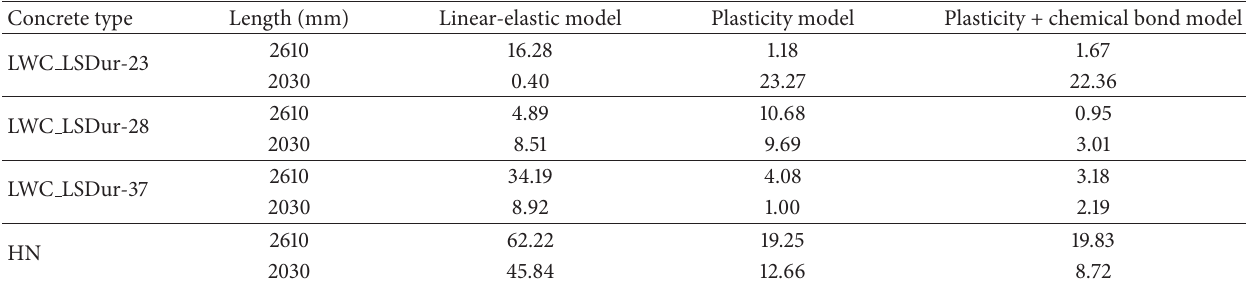
Figure 10: Numerical model results: (a) reaction force; (b) total deformation. Table 8: Comparison of errors (%) of the different models at the shear-bond failure region.